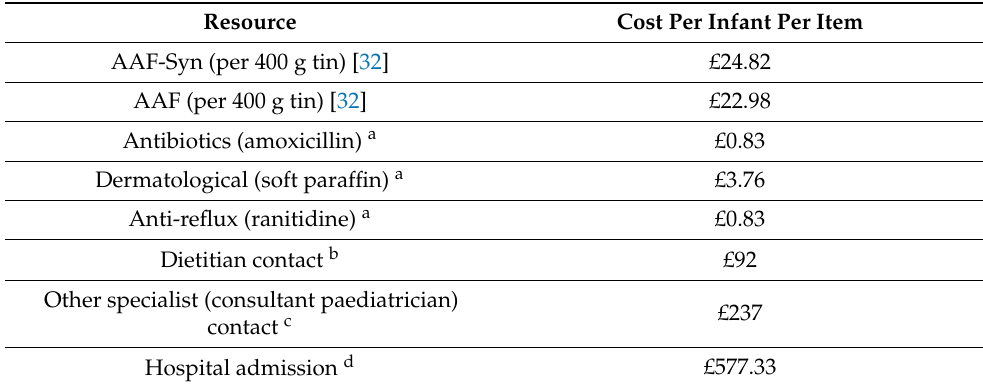
Table 1. A summary of cost estimates used in the indicative cost